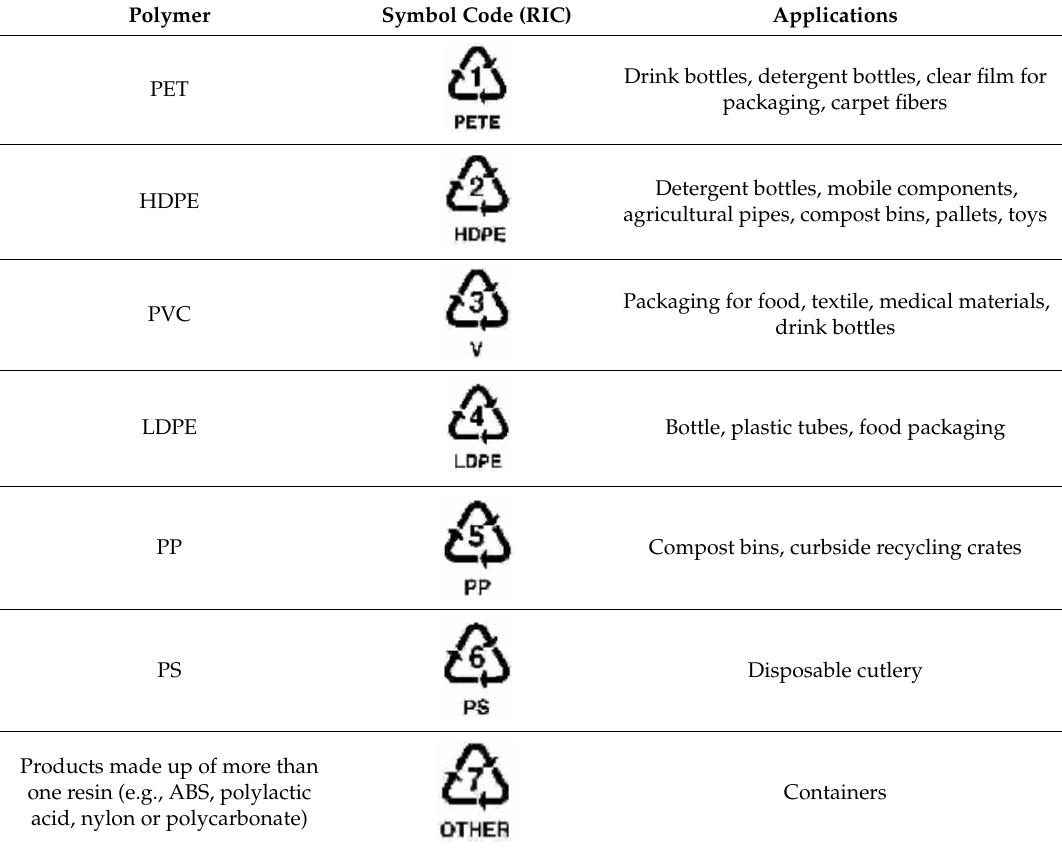
Figure 2. Flow chart of the recycling process until obtaining individual polymers [5]. Table 1. Symbols used for identification of polymers in WEEE. Adapted from Grigore (2017).